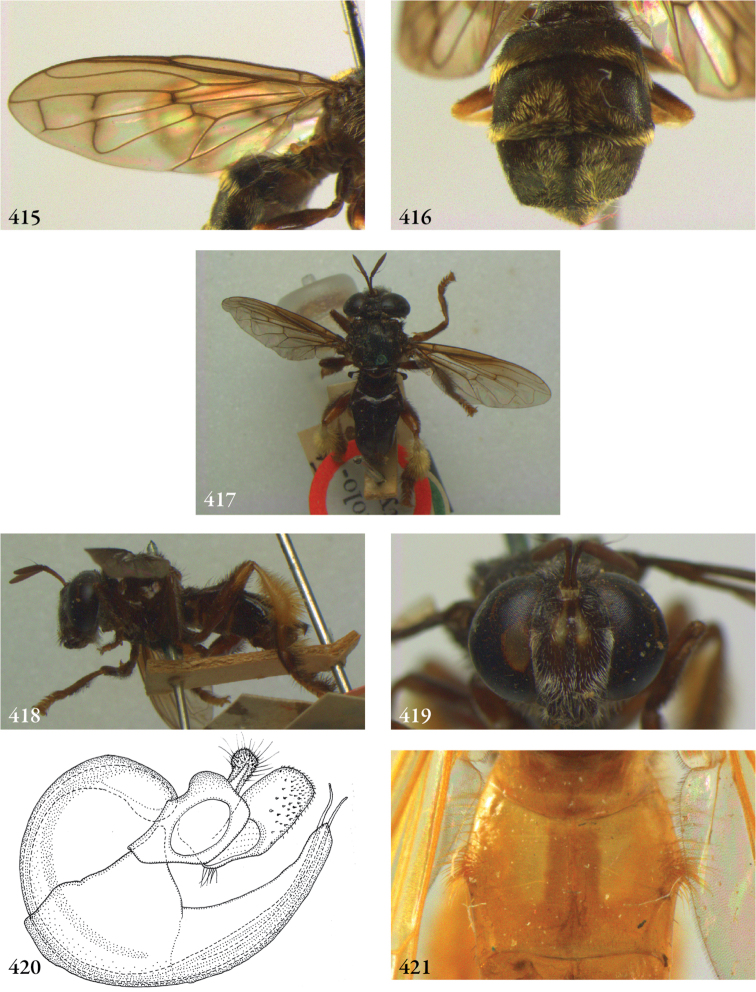
415–416
Thompsodon conspicillifrons female (holotype): 415 wing 416 abdomen dorsal 417–420
Ubristes flavitibia male (holotype) 417 habitus dorsal 418 habitus lateral 419 head frontal 420 genitalia lateral 421Ubristes spec. female (Brazil, coll. USNM), tergite 2 dorsal.